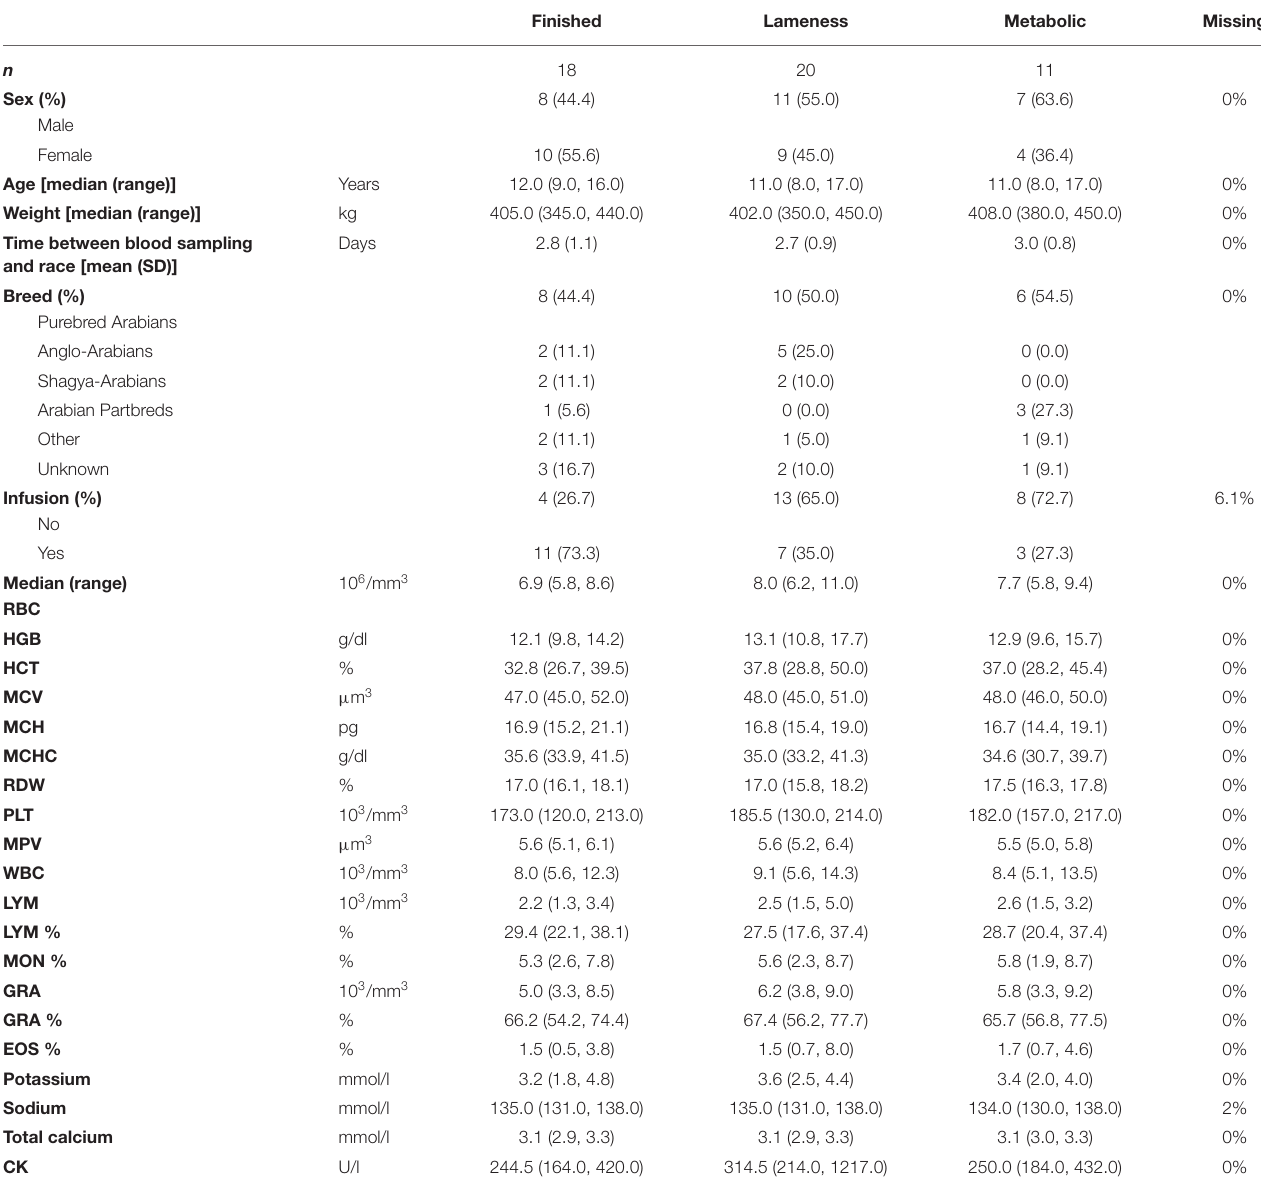
TABLE 1 | Distributional characteristics of the study population and summary statistics of blood values. Finished Lameness Metabolic